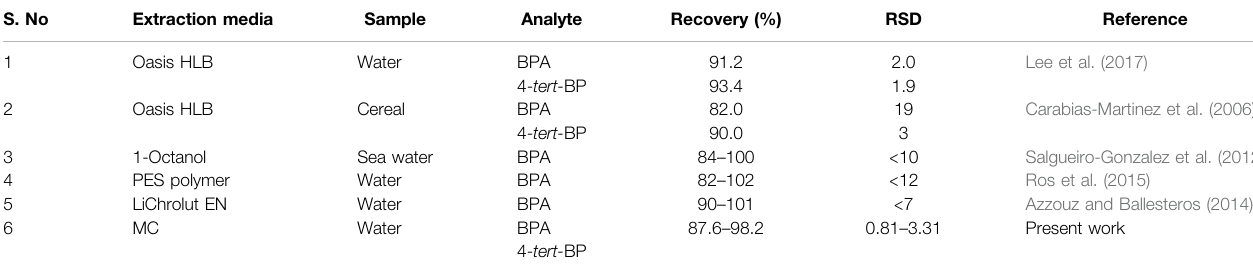
TABLE 5 | Comparison between the proposed solid-phase extraction method and literature data. S.